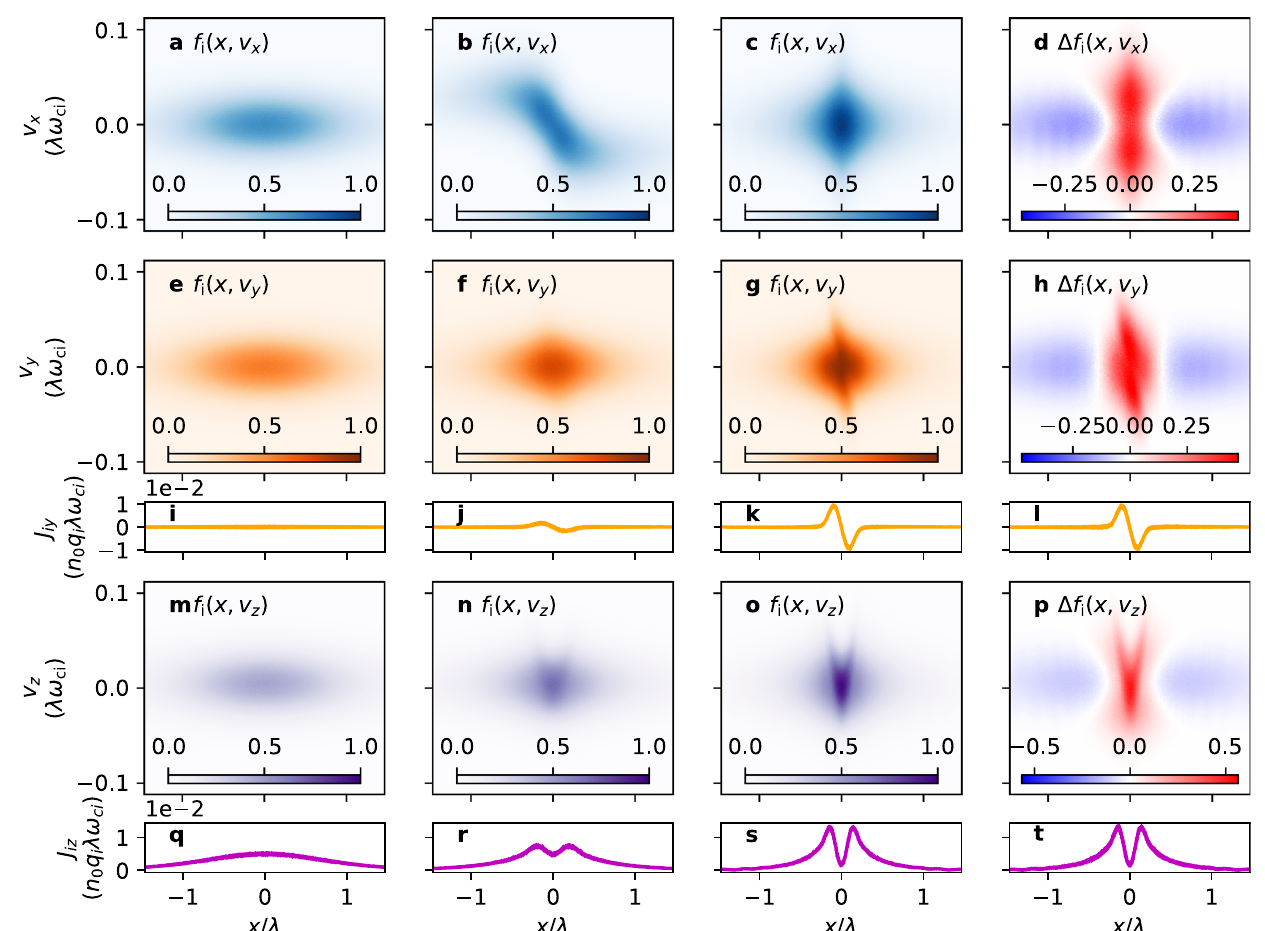
Fig. 5 | Timeevolution of f i fromthe particle-in-cell simulation. Ion distribution (cid:4) (cid:5) space at a t =0, b t =10 ω (cid:2) 1 ci , and c t =100 ω (cid:2) 1 ci . d The function f i in (cid:2) x , (cid:2) v x